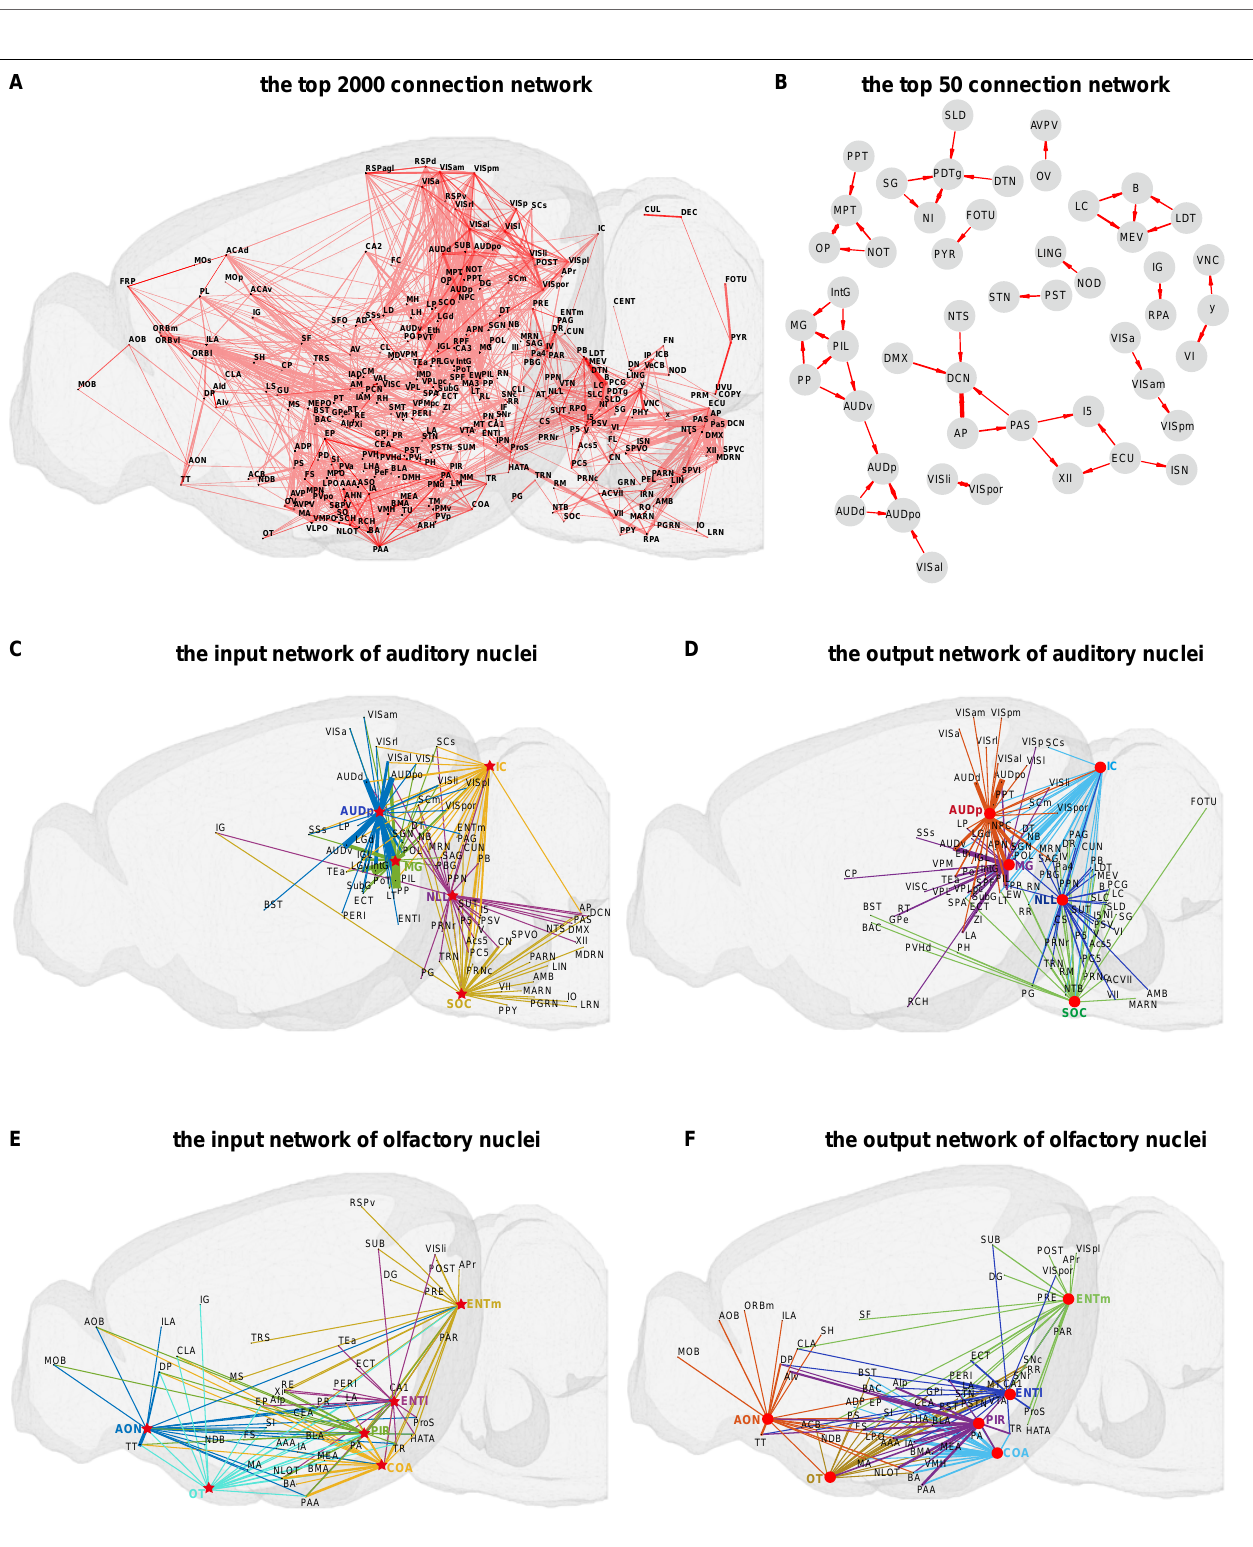
FIGURE 2 | Visualization of the connection network in mice brain. (A) The top 2,000 three-dimensional (3D) connection network. (B) The top 50 connection networks. (C,D) The input and output 3D connection networks of auditory nuclei. (E,F) The input and output 3D connection networks of olfactory nuclei. The arrows between the nuclei represent the projection direction, and the width of the line represents the projection intensity. Red circles and stars respectively represent the source and target nuclei in the auditory and olfactory networks.